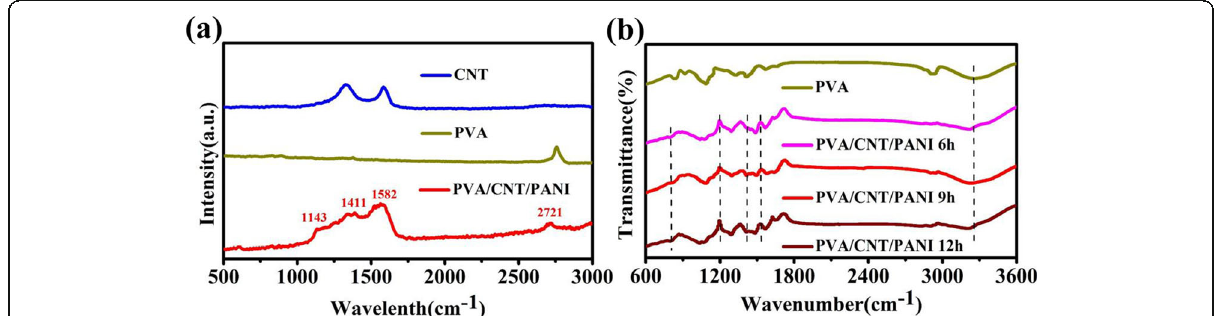
Fig. 4 a Raman spectra of CNT, pure PVA, and PVA/CNT/PANI film. b FTIR spectra of PVA and PVA/CNT/PANI